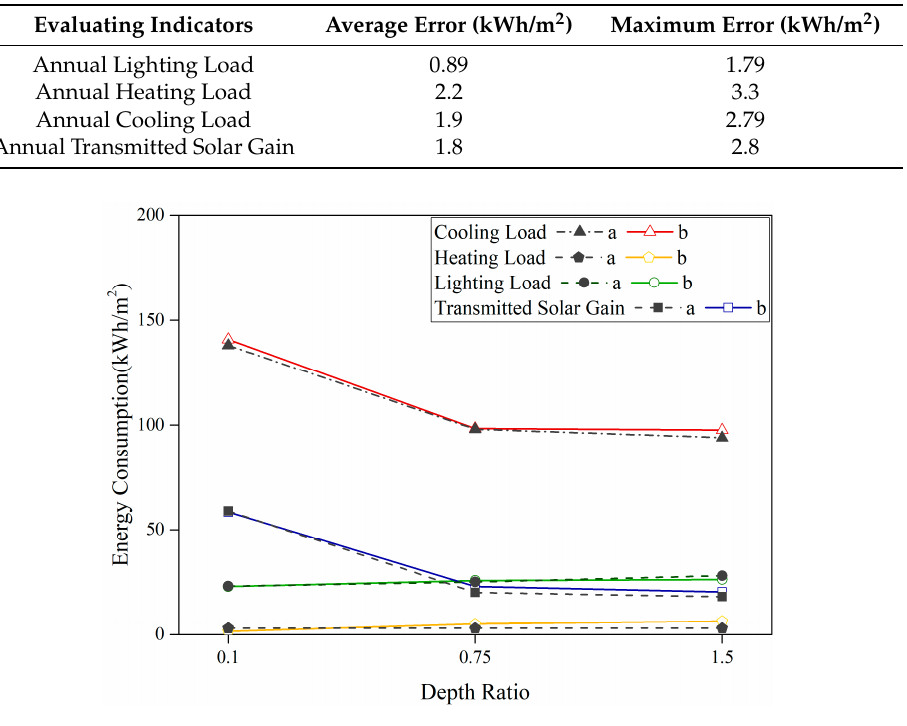
Figure 3. Annual energy consumption of different depth ratios: ( a ) Simulated data of the referenced study; and ( b ) simulated data of the verification model.